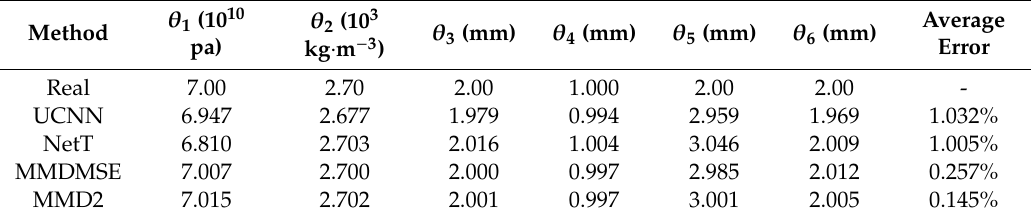
Table 2. Model updating result with 4000